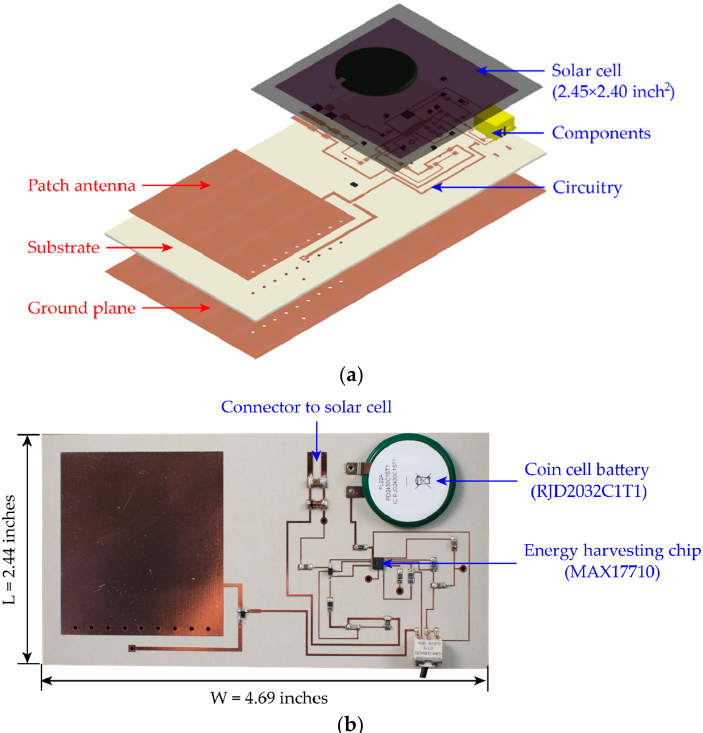
Figure 2. Dual ‐ mode patch antenna sensor: ( a ) design drawing, ( b ) picture of dual ‐ mode patch Figure 2. Dual-mode patch antenna sensor: ( a ) design drawing, ( b ) picture of dual-mode patch antenna antenna sensor (solar cell removed). sensor (solar cell